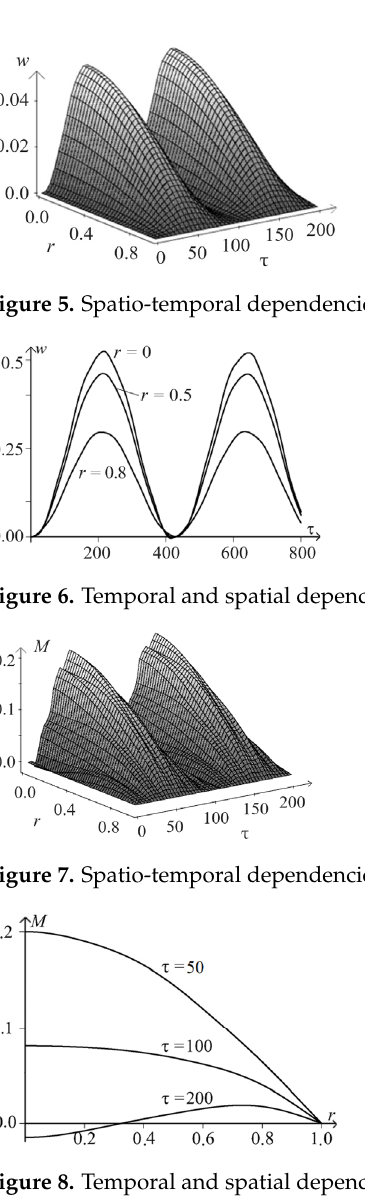
Figure 8. Temporal and spatial dependencies for deflection M ( r , τ )